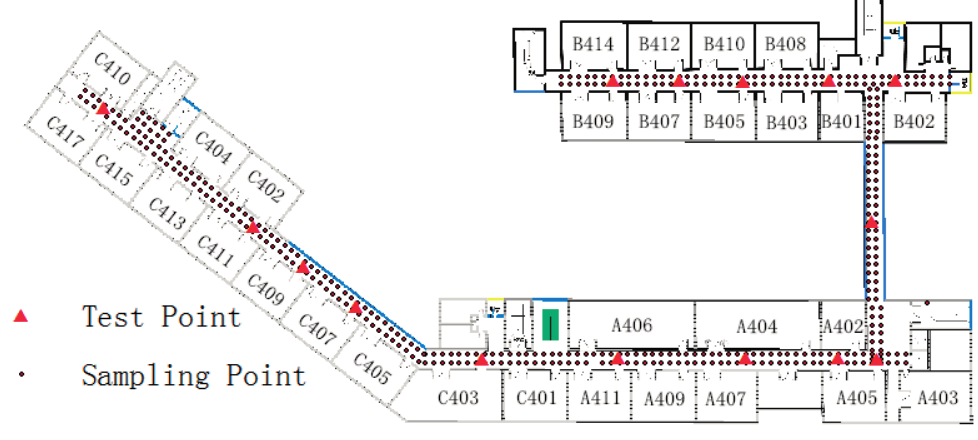
Figure 2. Distribution of sampling and test points.